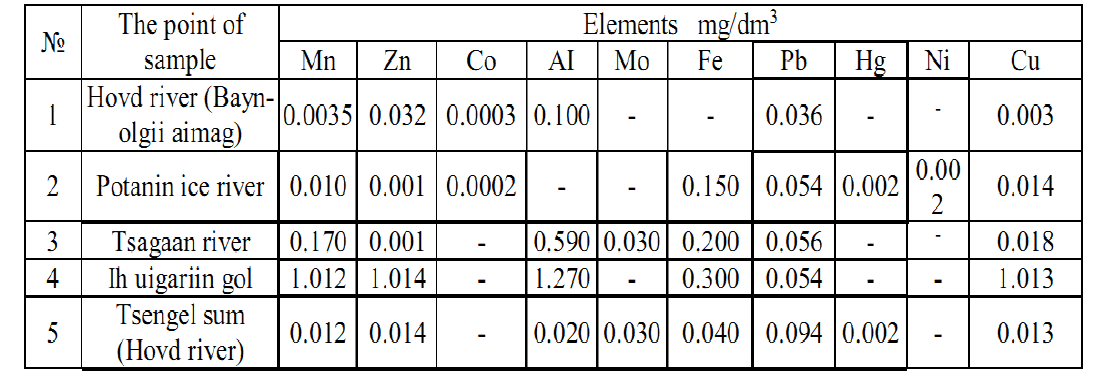
Table 2. Water elements of Hovd river and its river